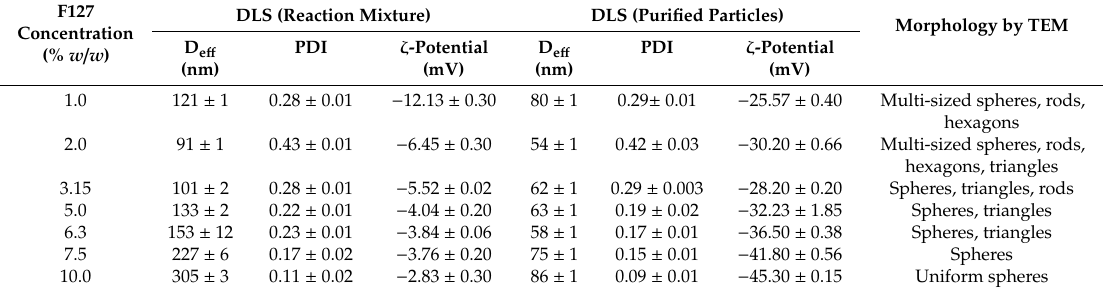
Table 2. E ff ect of F127 concentration on the characteristics of the GNP 1